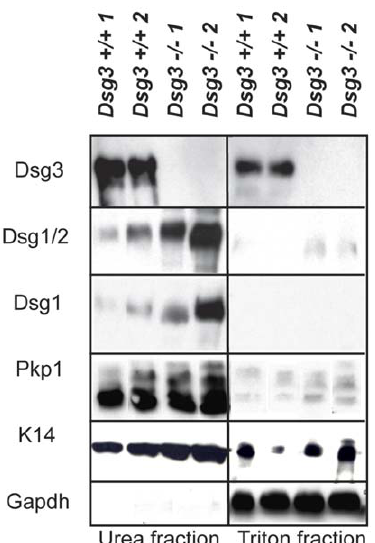
Figure 5. Dsg3 loss in the skin results in Dsg1 and Dsg2 upregulation. Western blot analysis showing both the Triton X-100- soluble and urea-only soluble fractions of mouse skin lysates from Dsg3 + / + and Dsg3 2 / 2 mice. 1 and 2 denote samples from two mice. GAPDH serves as a loading control for the Triton X-100-soluble pool, while Keratin 14 serves as the loading control for the urea fraction.